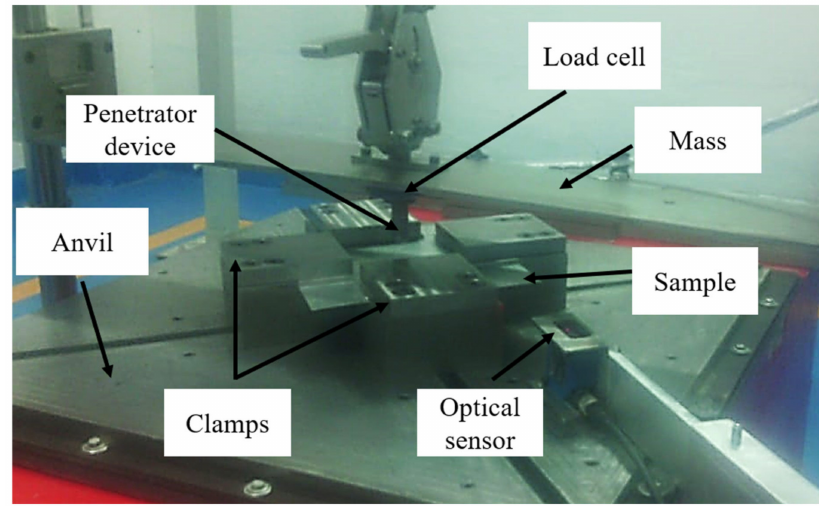
Figure 4. Experimental arrangement of the free–fall impact test.